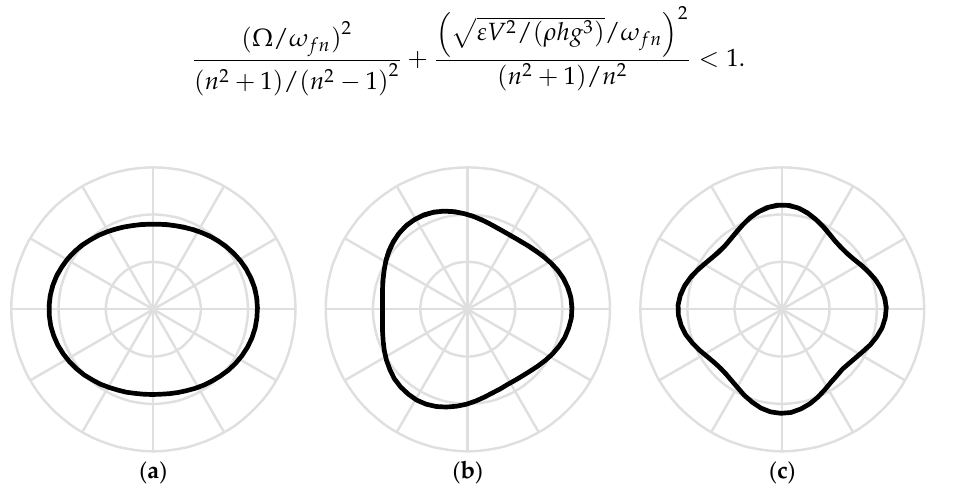
Figure 4. The stationary modes when Ω and V satisfy Equation (40). ( a ) n = 2; ( b ) n = 3; ( c ) n = 4.